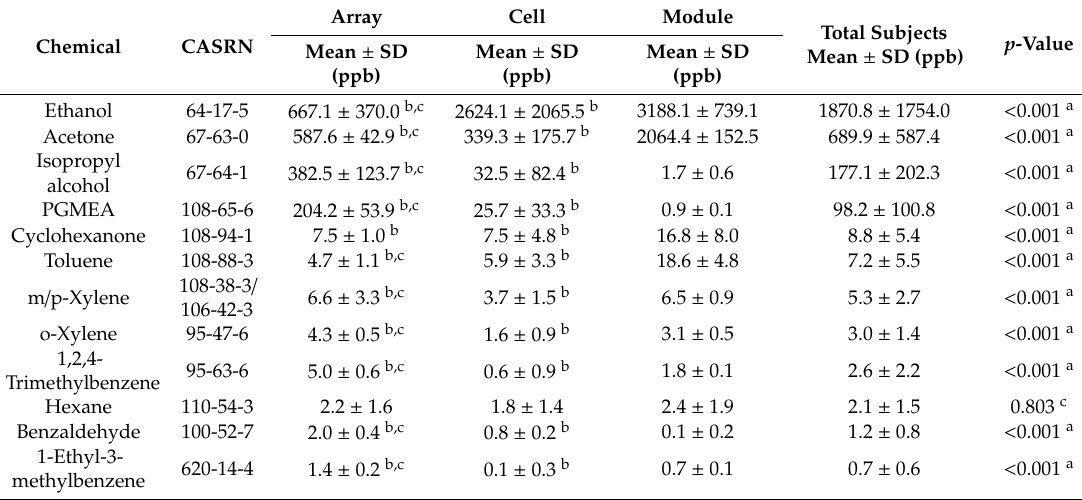
Table 2. Mean values ± stand deviation of exposure levels of volatile organic compounds (VOCs) by study